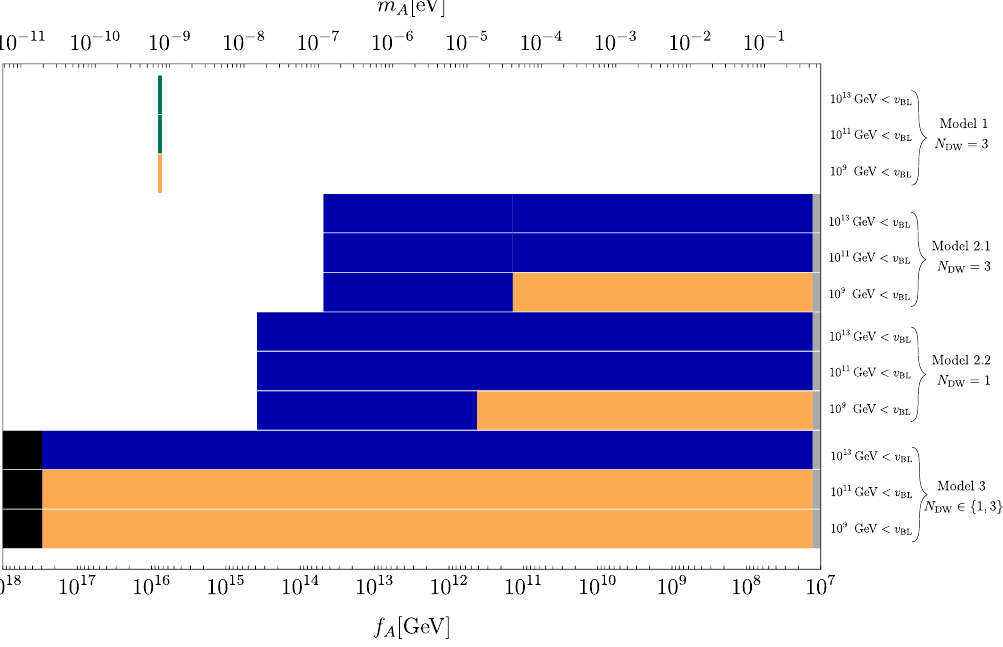
Possible ranges of the axion mass and decay constant consistent with gauge coupling uni(cid:12)cation in our models, for the case where all heavy scalars are degenerate at their various threshold scales. Regions in black are excluded by constraints from black hole superradiance, regions in blue by proton stability constraints. Regions in green are disfavoured depending on the allowed range of the B-L breaking scale. Regions in gray are excluded by stellar cooling